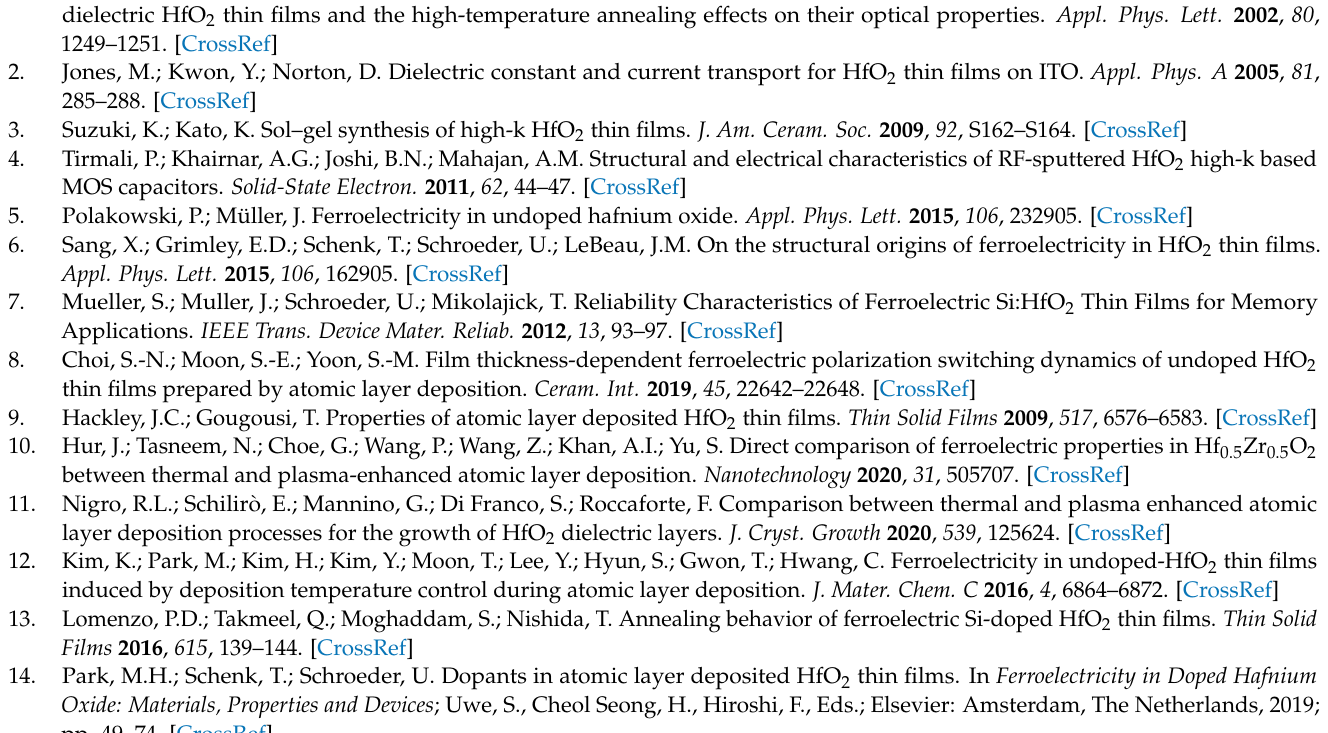
chamber.; Figure S2: The pressure log of a supercycle consisting of TDMAHf half cycle (TDMAHf dose–purge) and O 2 plasma half cycle (O 2 plasma dose–purge).; Figure S3: An example of SE data analyzed using Cauchy equation.; Figure S4: The Hf 4f HRXPS spectra deconvoluted into four peaks of the HfO 2 films deposited at different O 2 plasma conditions. (Top panel: O 2 flow rate 10 sccm, lower panel: O 2 flow rate 50 sccm, left panel: O 2 plasma power 20 W, right panel: O 2 plasma power 300